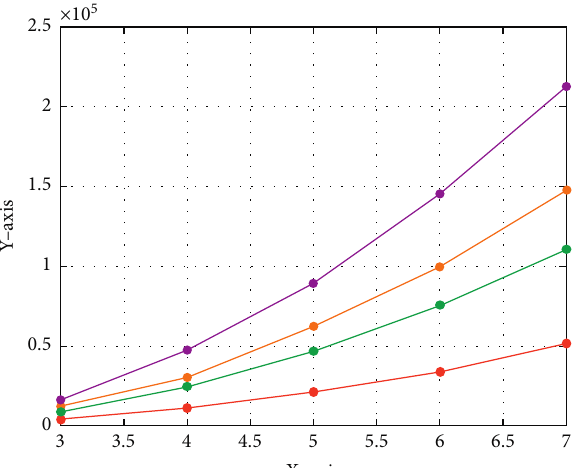
P ) , HZ ( P P ) , HZ ( P P ) , and HZ ( P n 1 ⊠ S 1 m n 1 ⊠ R 1 m n 1 ⊠ Q 1 m